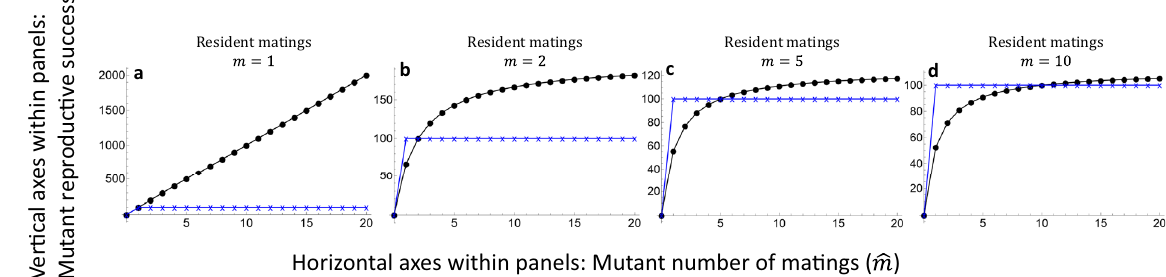
Fig. 4 The Bateman functions of Eqs. (2) – (4) when the resident number of matings varies. The gametic system is anisogamy with n x = 100 (female, indicated by blue crosses and connecting lines), n y = 100,000,000 (male, indicated by black dots and connecting lines). The number of resident matings m varies between a – d as indicated above the panels. Results are visually indistinguishable for Models 2-3 and with fertilisation ef fi ciency parameters a = 0.001/ a = 1. Increased number of resident matings (i.e., increased gamete competition) decreases the steepness of the male Bateman gradient but does not eliminate the asymmetry between female and male gradients, in line with earlier theoretical results by Parker and Birkhead